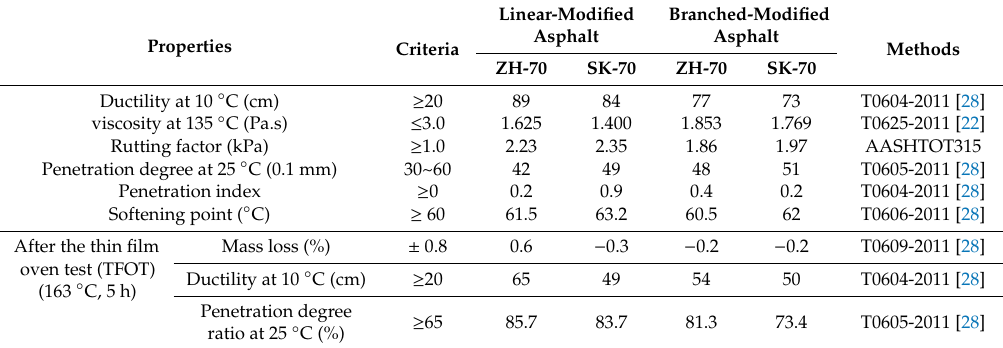
Table 3. Properties of SBS-modified asphalt.